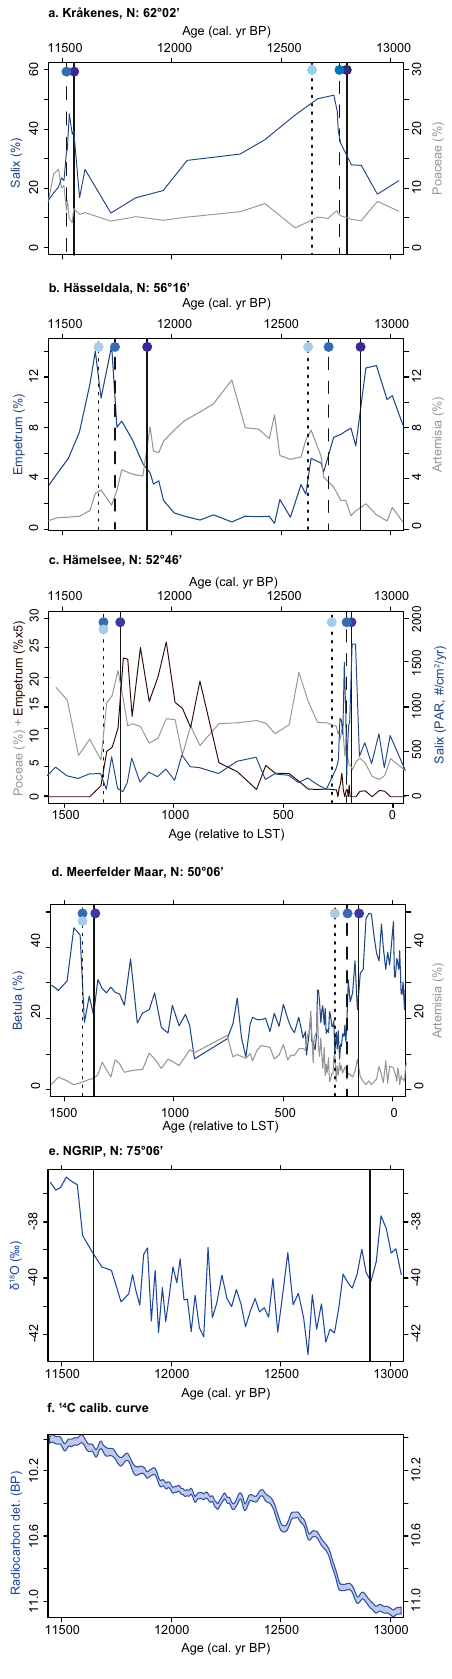
Fig. 3 Summary records of terrestrial ecosystem change for sites on a N-S transect across northwest Europe. Selected pollen taxa (%) are shown for a Kråkenes; b Hässeldala; c Hämelsee; d Meerfelder Maar. Solid vertical lines indicate the earliest onset of vegetation response to climate change (YD early and HOL early bold/ dark blue circle), dashed vertical lines (/blue circle) indicate the onset of the YD and Holocene sensu stricto (YD SS and HOL SS ) and dotted lines (/light blue circle) the point where a new equilibrium was reached in the pollen spectra (YD eq and HOL eq ). The e NGRIP δ 18 O record 1 with vertical lines showing the onset and end of GS-1 and f IntCal20 radiocarbon calibration curve 29 are shown for comparison. All data are plotted on the IntCal20 timescale in cal. yr BP, except for the Meerfelder Maar record which is plotted in years relative to the LST datum (see Methods for more